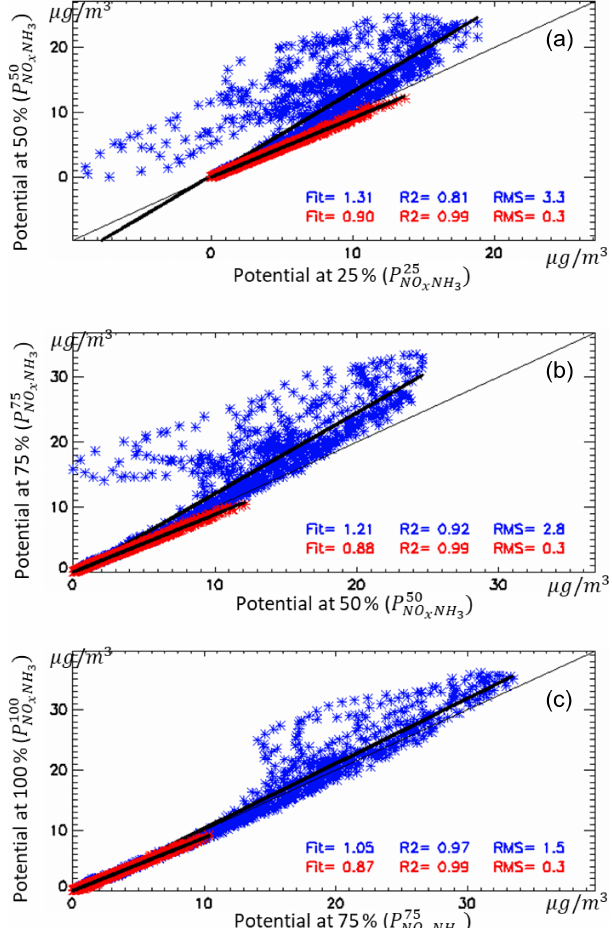
Figure 11. Changes in the overall non-linearity terms from 25% to 50% (a) , from 50% to 75% (b) and from 75% to 100% (c) in NO x and NH 3 . The overall non-linearity is visualised as the dis- tance from the 1 : 1 diagonal, i.e. the difference between the overall potential impact at two levels of emission reduction, x and y axis. Each point represents one land grid cell within the domain for win- tertime (blue) and summertime (red). The “fit” parameter indicates the slope of the regression line, while R2 and RMS provide infor- mation on the coefficient of determination and the root mean square error,